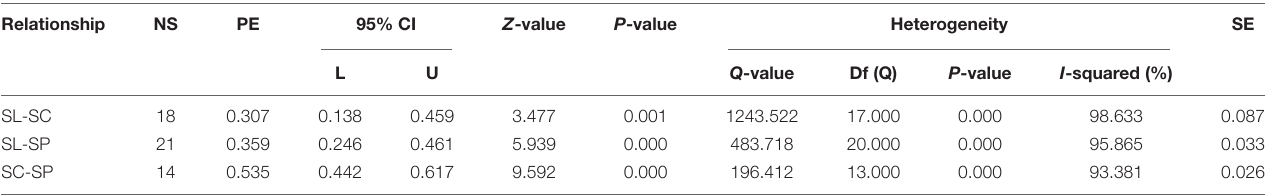
TABLE 4 | Overall effects of the relationship among SL, SC, and SP.